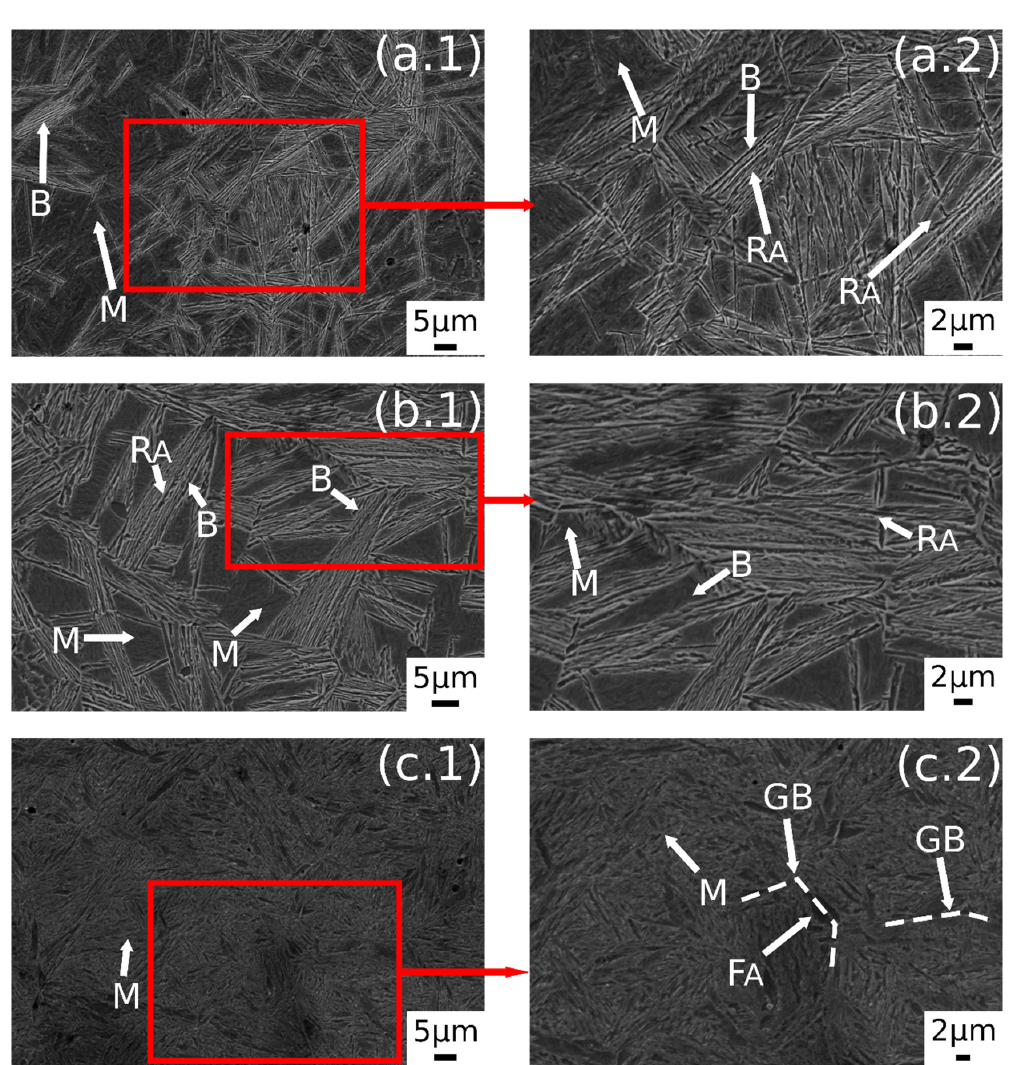
Figure 5. SE - SEM images of the surfaces of the samples: ( a.1 , a.2 ) 900 °C + 300 °C, ( b.1 , b.2 ) 900 °C + 350 °C, ( c.1 , c.2 ) 900 °C + 400 °C. (M martensite, F ferrite, R A retained austenite, B carbide free bainite, GB prior austenite grain boundary, F A allotriomorphic ferrite).